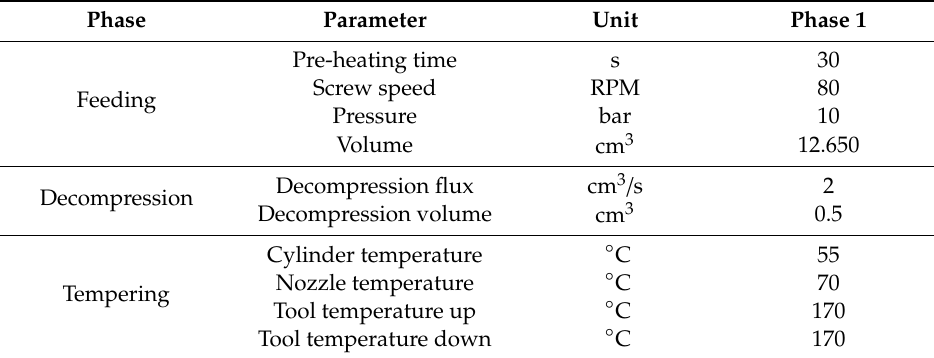
Table A2. Injection molding auxiliary parameters.